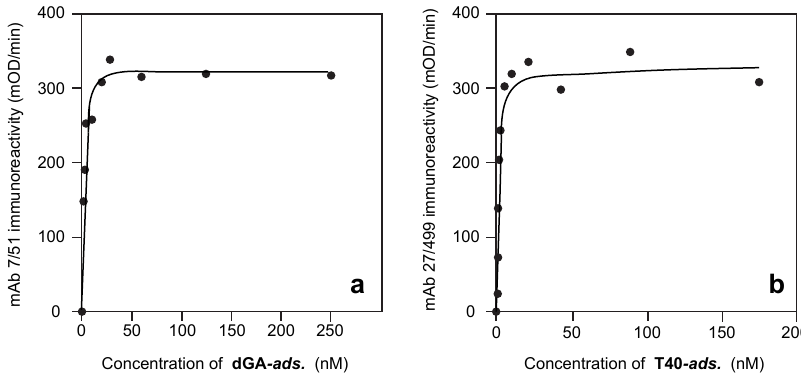
Figure 3. Non-specific binding of dGA ( a ) or full-length tau ( b ) to the solid-phase PVC matrix. Binding was detected using mAbs 7/51 or 499, respectively. In both instances, saturation of non-specific binding sites occurred at plating concentrations greater than 20